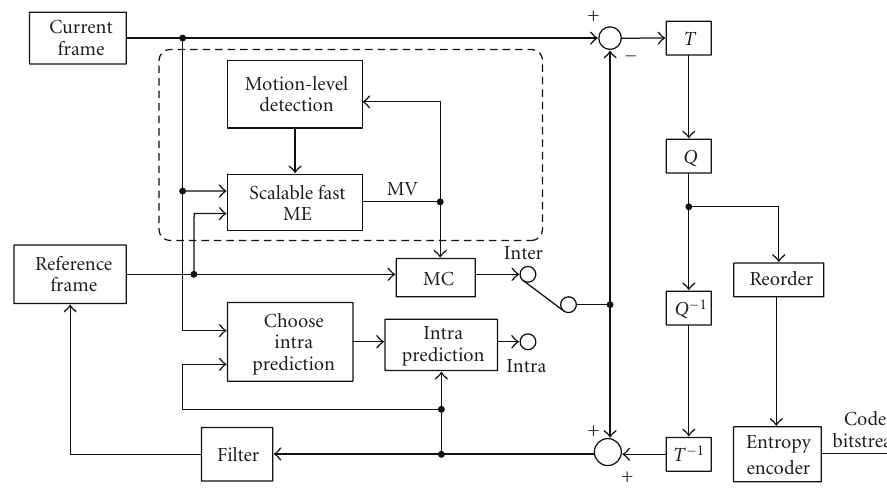
Figure 1: The proposed system diagram for H.264/AVC